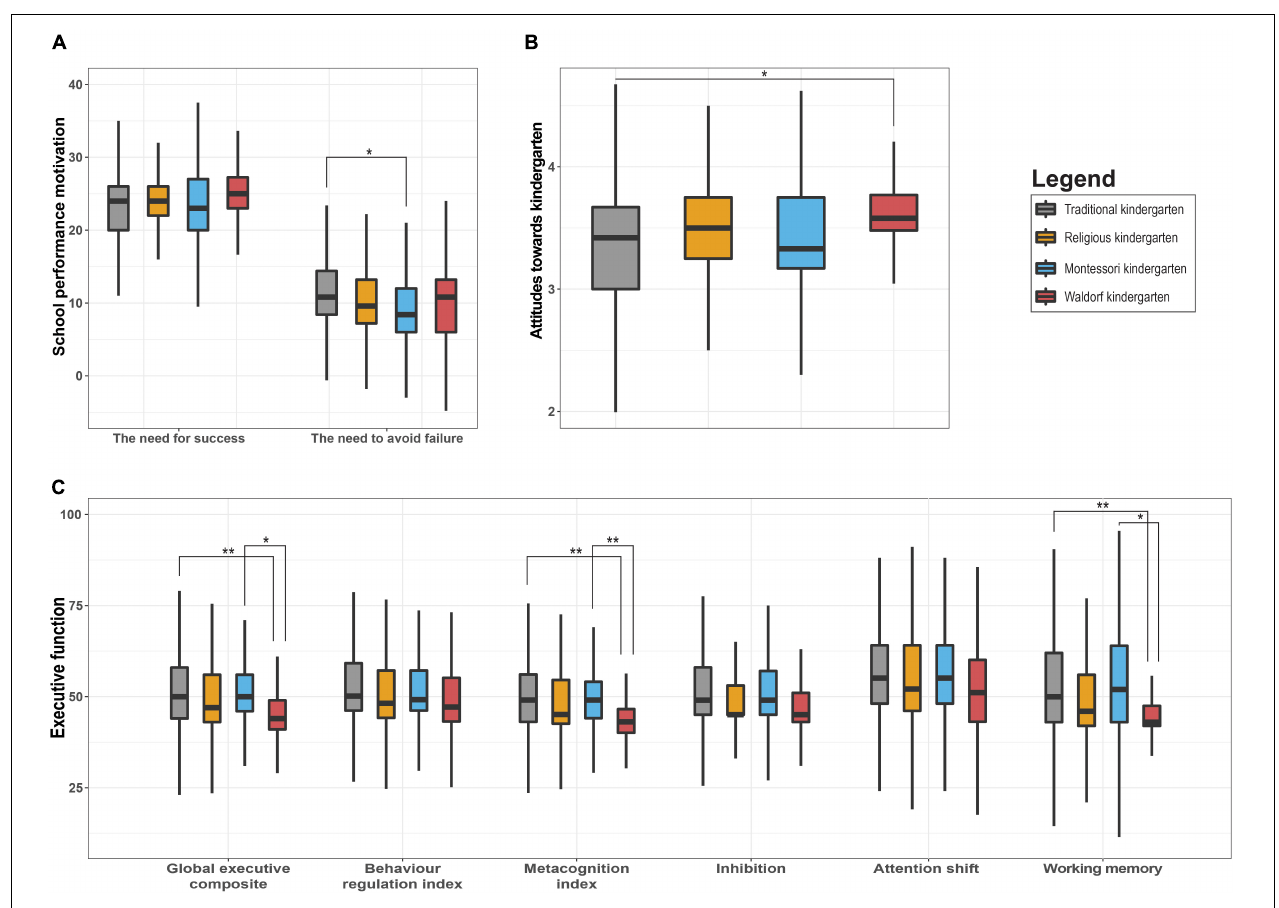
FIGURE 1 | Differences in school performance motivation (A) , attitudes toward kindergarten (B) , and executive functions (C) in different types of kindergartens. The boxplots show the differences in the medians and IQRs of children from individual kindergarten types. The horizontal upper bars represent the differences between individual types of kindergartens with indicated levels of significance (* P < 0.05, ** P <